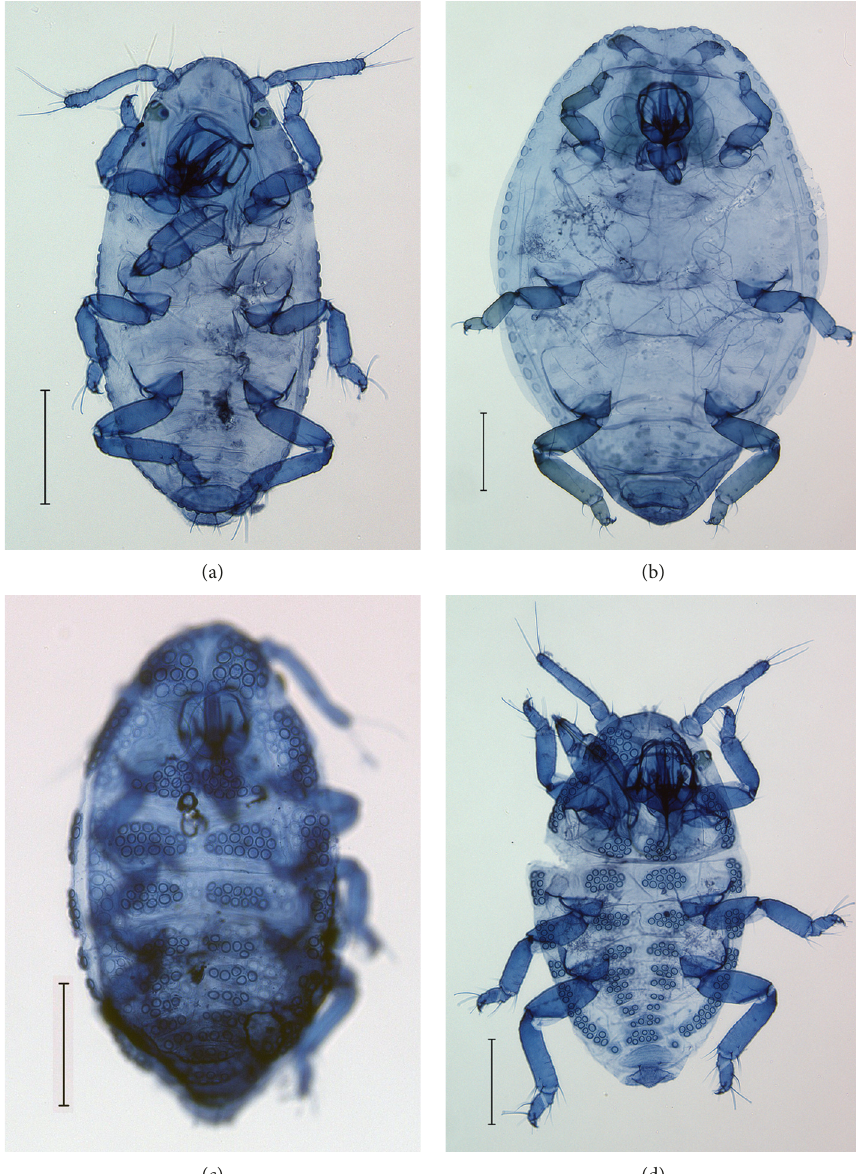
Figure 4: Nymphs of Neothoracaphis glaucae : (a) first-instar nymph to be aptera (collected on 5 November 2014); (b) nonfirst (probably third) instar nymph to be aptera (collected on 8 February 2013); (c) first-instar nymph to be alate (collected on 1 November 2013); (d) first- instar nymph produced by the alate (fixed on 1 December 2013). All aphids were collected from Quercus glauca in Shinkiba, Tokyo, Japan. Scale bars: 100 μ